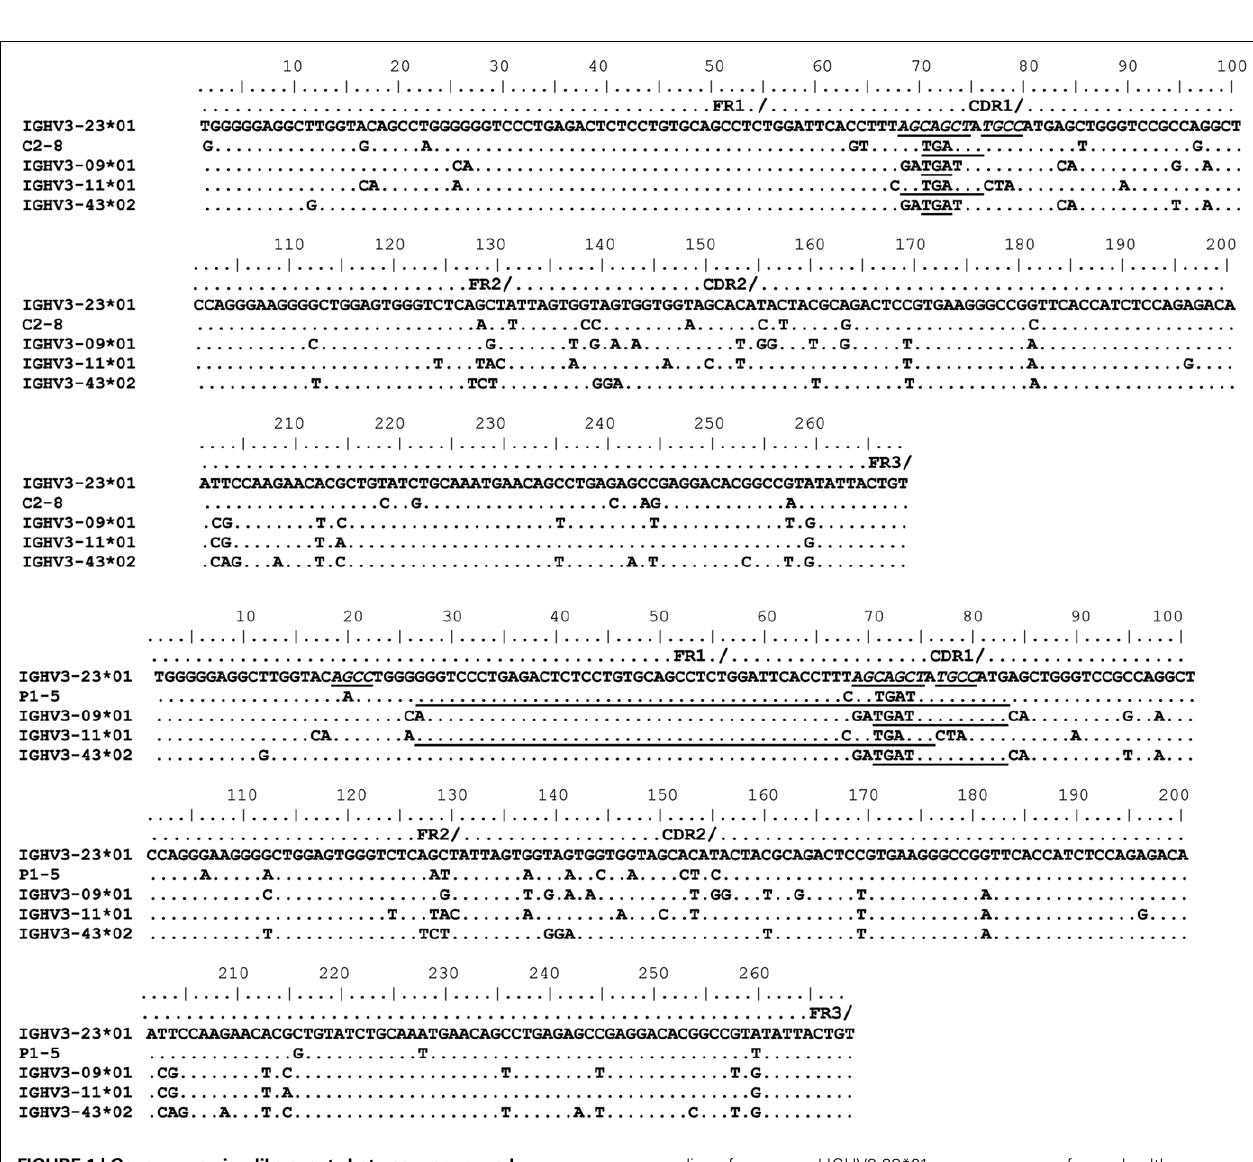
FIGURE 1 | Gene conversion-like events between rearranged IGHV3-23*01 gene sequences and germlineVH sequences identified by GENECONV. Alignments of rearranged IGHV3-23*01 gene sequences and germline donorVH sequences demonstrating the minimum and maximum homology at GCV-like events.Topmost sequence is the